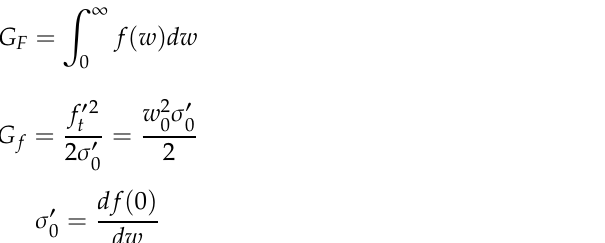
Figure 3. Bilinear tensile softening curve of concrete.